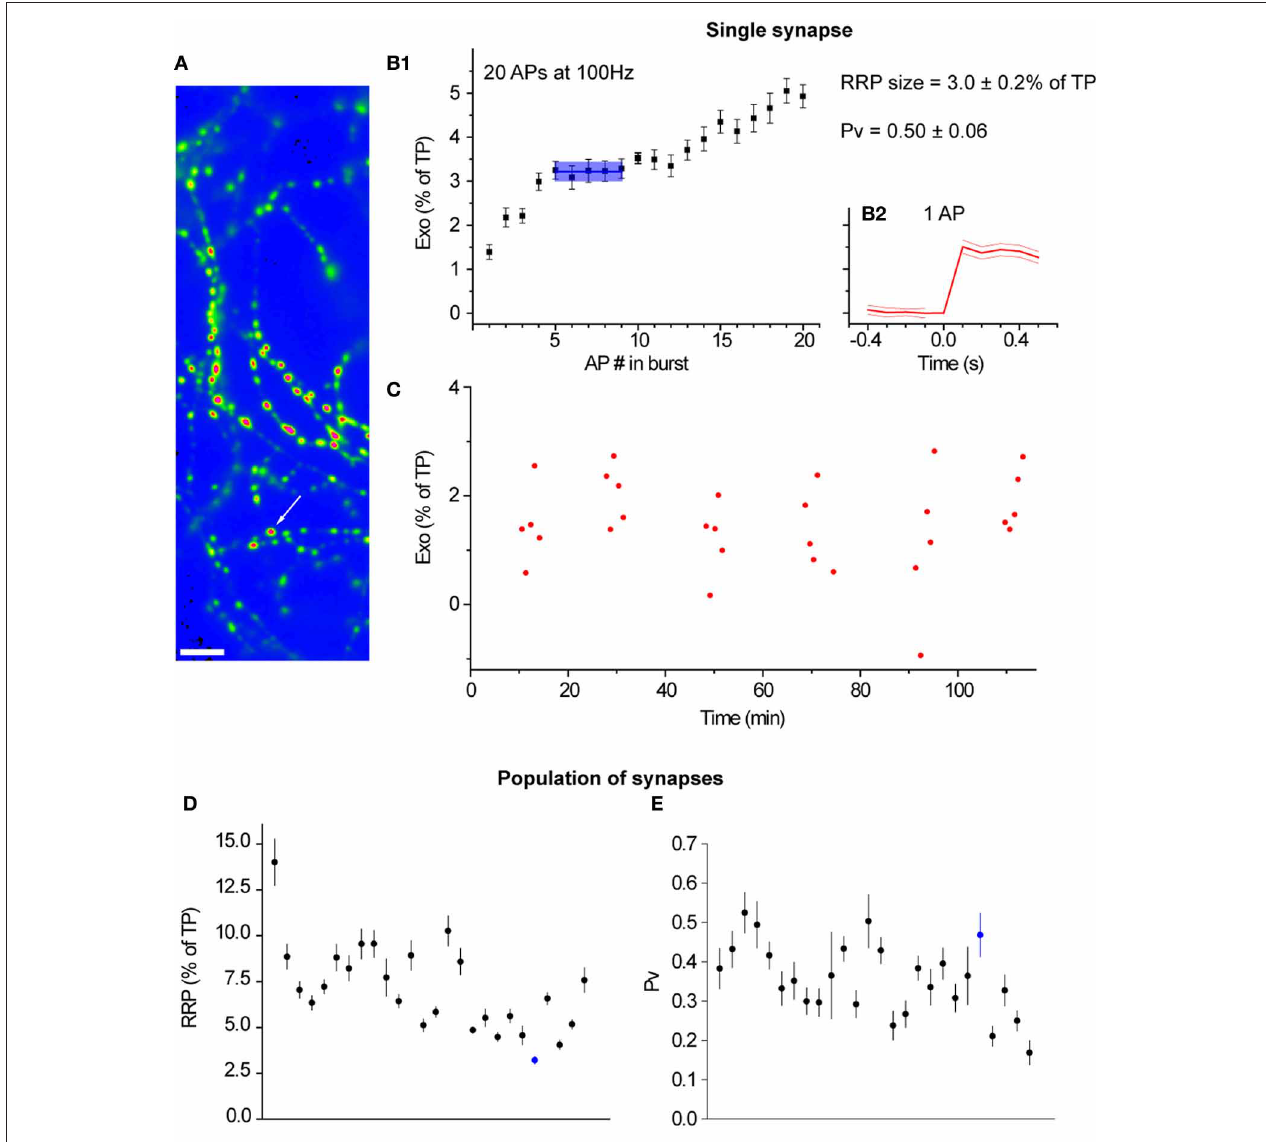
FIGURE 1 | Pv and RRP size can be measured precisely at many individual synapses in parallel. (A) Field of boutons in a representative experiment. The image is the difference in fluorescence before and after the application of 50mM NH 4 Cl and is smoothed for presentation purposes only. The arrow marks the synapse shown in detail in the rest of the figure. Scale bar = 5 μ m. (B1) Cumulative exocytosis in response to 20 APs at 100Hz for the indicated synapse ( n = 12 trials). The blue line indicates the RRP size. The light blue shading indicates the region where a plateau, indicative of exhaustion of the RRP, was detected using our methods, along with the SE in the RRP size (see Materials and Methods). (B2) Exocytosis in response to a